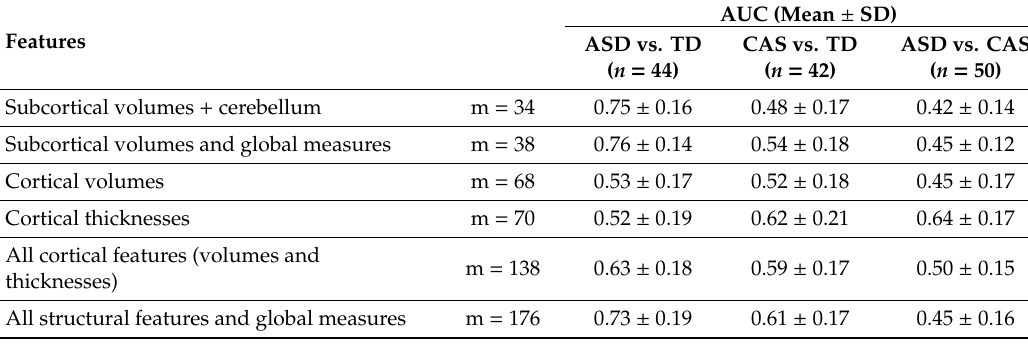
Table 3. Classification performance in the binary classification between the ASD vs. TD, CAS vs. TD and ASD vs. CAS groups using structural features. The performances are expressed in terms of the area under the ROC curve (AUC) achieved in the classification of di ff erent groups of features (e.g., cortical volumes / thickness, subcortical volumes, global volumes and their combinations). The cross-validation scheme implemented consisted in 10 repetitions of a five-fold cross